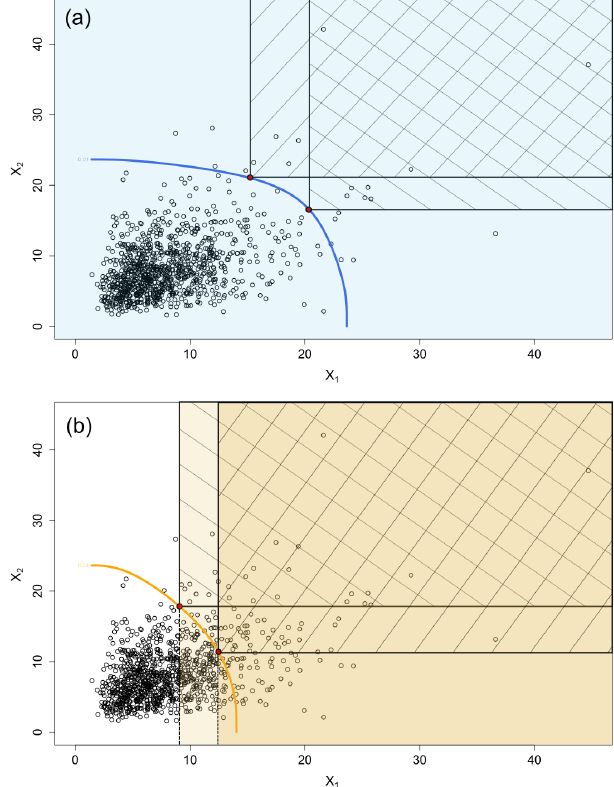
Figure 4. Graphical representation of two bivariate ( X 1 , X 2 ) prob- abilities of exceedance: (a) P AND probability and (b) P COND prob- ability, with level curves (blue in a and orange in b ) representing p = 0 . 01 (1000 data points on a Gumbel copula with log-normal marginal distributions). Colours represent the domain on which the probabilities are computed while the areas with diagonal hatching represent the critical regions which are the regions corresponding to the given